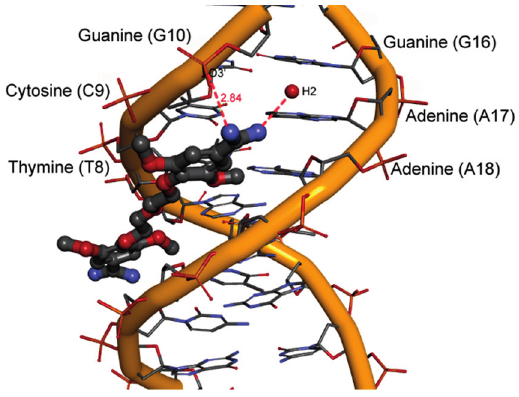
Figure 10. A view of one hydration site for compound 8 in the minor groove (red lines–hydrogen bonds; length